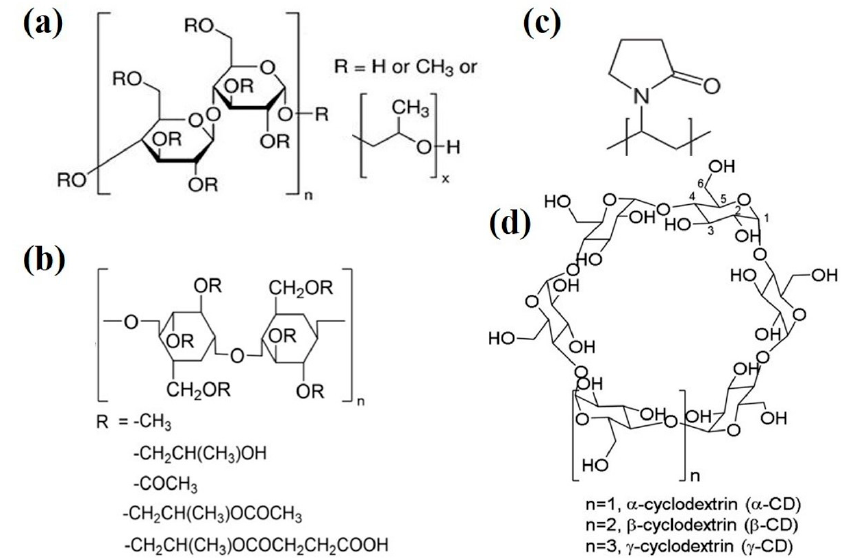
Figure 2. The molecular structures of commonly used precipitation inhibitors ( a ) Hydroxypropyl methylcellulose (HPMC), ( b ) Hydroxypropyl methylcellulose-acetate succinate (HPMCAS), ( c ) Pol- yvinyl pyrrolidone (PVP) and ( d )